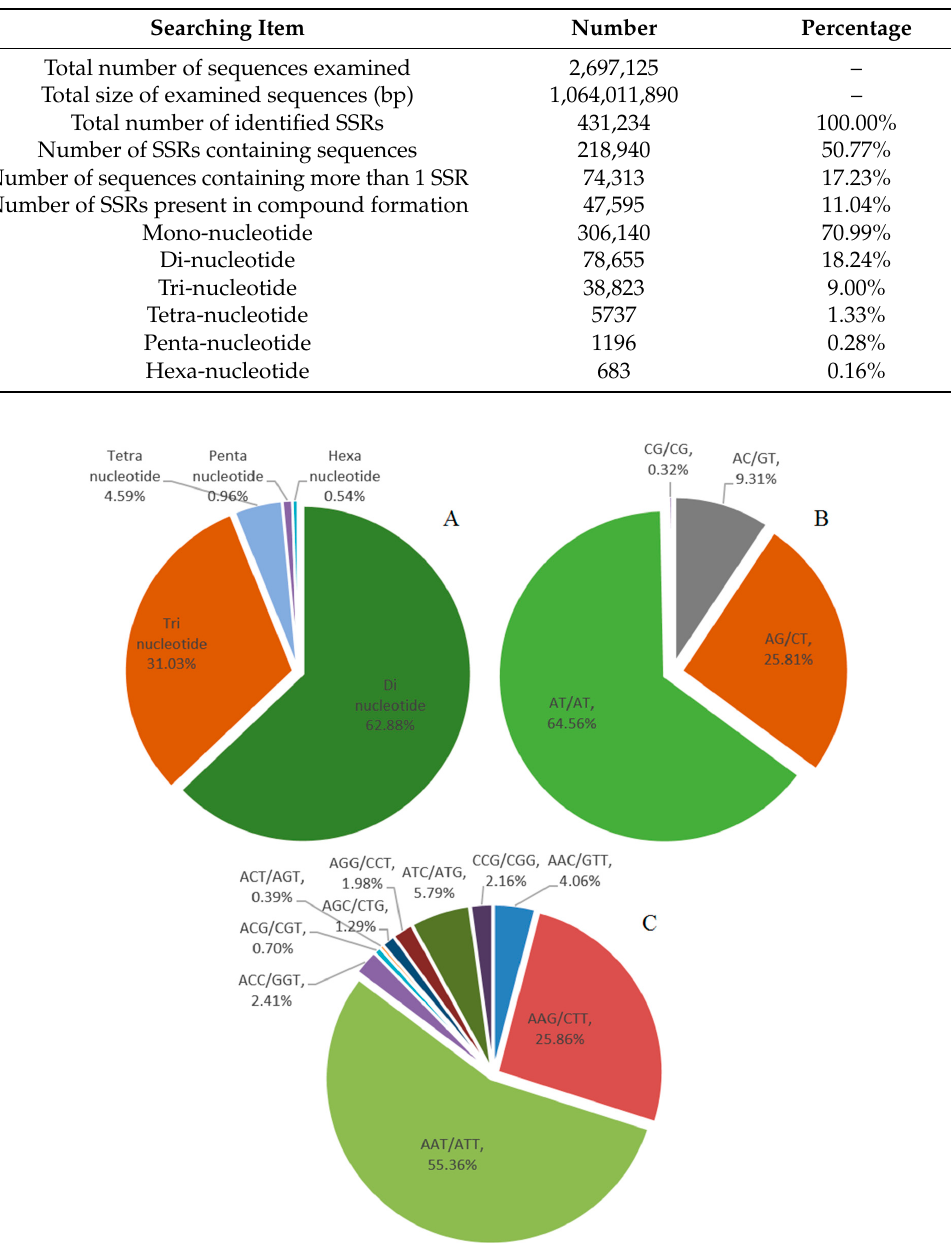
Table 3. Simple sequence repeat types detected in the Luffa cylindrica L. sequences.